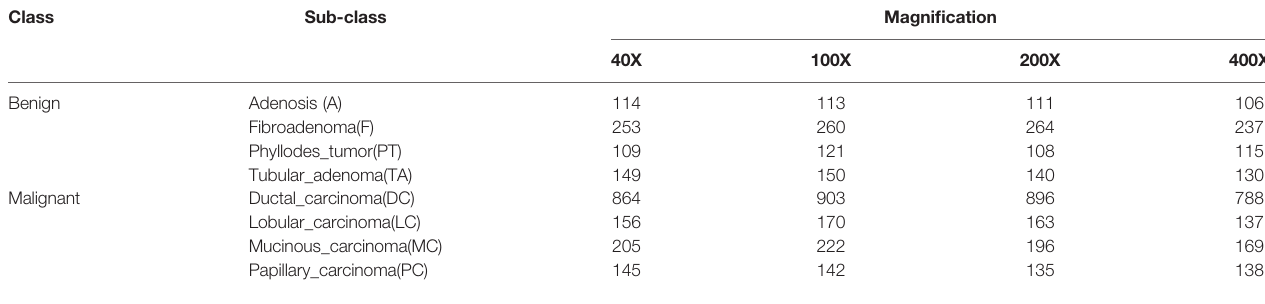
TABLE 2 | Image distribution by magni fi cation factor and subclass.